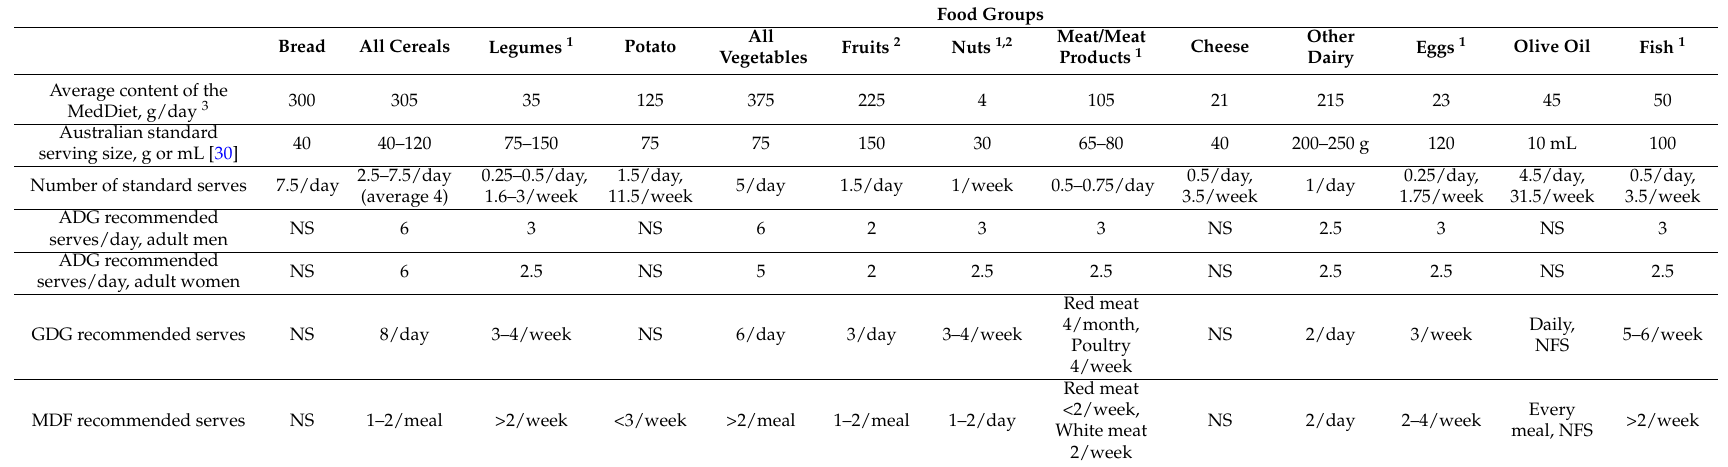
Table 3. Servings of food groups in the Mediterranean diet, calculated as standard Australian serving sizes, compared to Australian Dietary Guidelines [30], Greek Dietary Guidelines [22] and Mediterranean Diet Foundation [5]